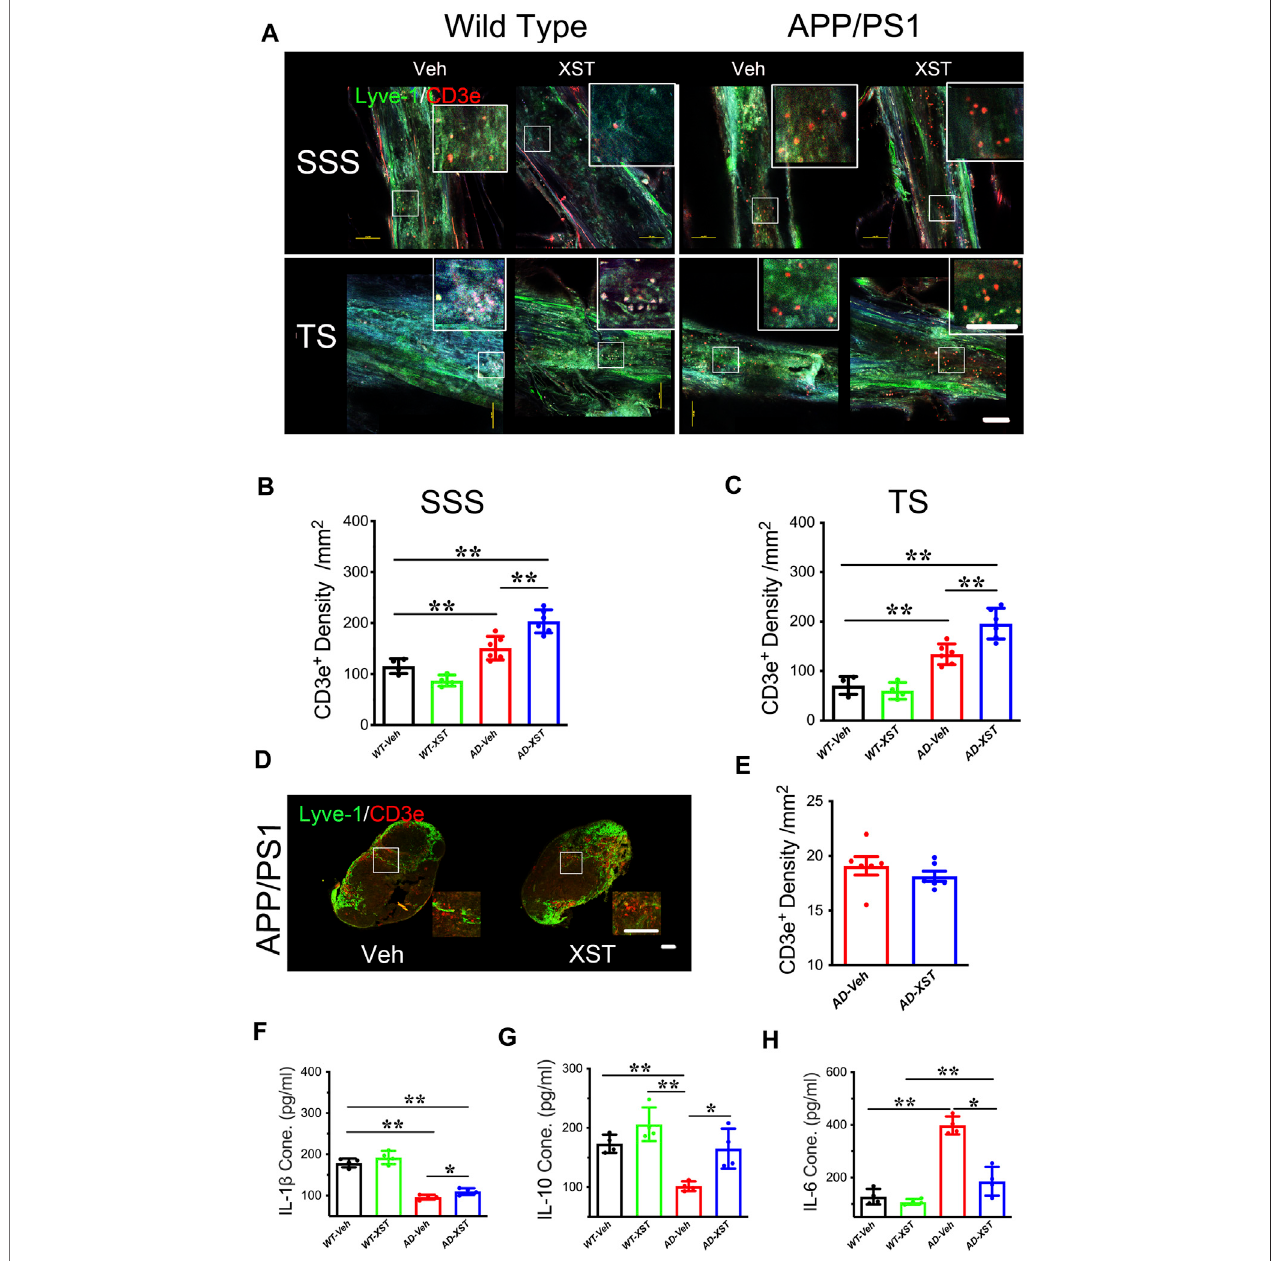
FIGURE3| Effect ofXST onin fl ammatory responsesinthebrainsofAPP/PS1 mice. (A) Sampleimages oflymphaticducts (Lyve-1, green)and T-cells(CD3e, red) in SSS region and TS region, in WT and APP/PS1 mice treated with either XST or Veh. Scale bar, 100 μ m. (B) Quanti fi cation of T-cell density in lymphatic ducts of the SSS region in WT and APP/PS1 mice treated with XST or Veh (F (1, 16) (cid:2) 70.96, C57 vs. AD, p < 0.0001; AD-Veh vs. AD-XST, p (cid:2) 0.0017, two-way ANOVA with Bonferroni ’ smultiplecomparisons). (C) Quanti fi cationoftheT-celldensityinlymphaticductsoftheTSregioninWTandAPP/PS1micetreatedwithXSTorVeh (F (1,16) (cid:2) 86.28,C57vs.AD, p < 0.0001;AD-Vehvs.AD-XST, p (cid:2) 0.0019,two-wayANOVAwithBonferroni ’ smultiplecomparisons). (D) SampleimagesofT-cellsin the lymph nodes of the neck. T-Cells (CD3e, red); lymph nodes (Lyve-1, green). Scale bar, 200 μ m (low). Scale bar, 100 μ m (high). (E) Quanti fi cation of T-cells densityinthelymph nodesoftheneck regioninXST-or Veh-treated APP/PS1mice( p (cid:2) 0.3483, t -test, n (cid:2) 6miceper group). QuantitativemeasurementofIL-1 β (F) (F (1, 12) (cid:2) 232.5, C57 vs. AD, p < 0.0001; AD-Veh vs. AD-XST, p (cid:2) 0.0279, two-way ANOVA with Bonferroni ’ s multiple comparisons); IL-6 (G) (F (1, 12) (cid:2) 94.89, C57 vs. AD, p < 0.0001; AD-Veh vs. AD-XST, p (cid:2) 0.014, two-way ANOVA with Bonferroni ’ s multiple comparisons); and IL-10 (H) (F (1, 12) (cid:2) 22.63, C57 vs. AD, p (cid:2) 0.0005; AD-Veh vs. AD-XST, p (cid:2) 0.0155, two-way ANOVA with Bonferroni ’ s multiple comparisons). Levels in serum in WT and APP/PS1 mice ( n (cid:2) 4 mice per group). Data are mean ± SEM. IL: interleukin. * p < 0.05; ** p < 0.01.